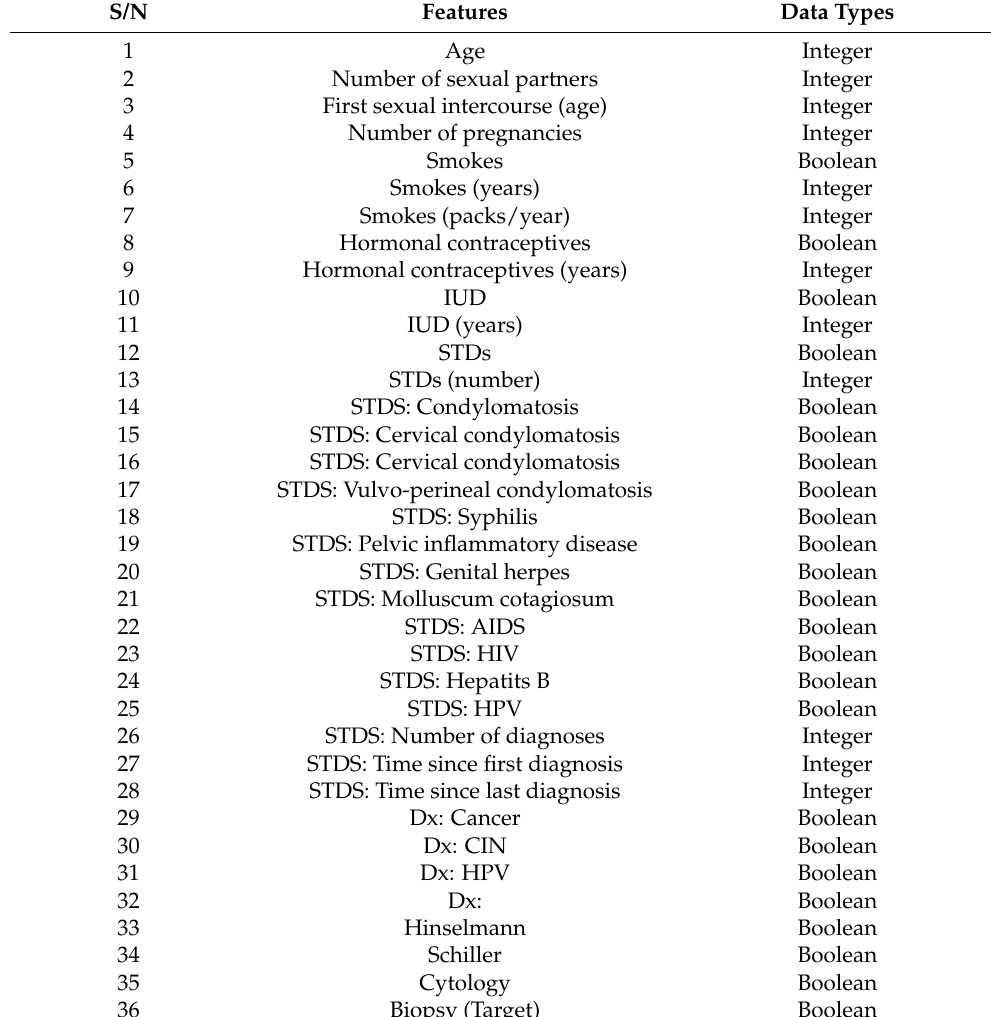
Table 1. Characteristics of